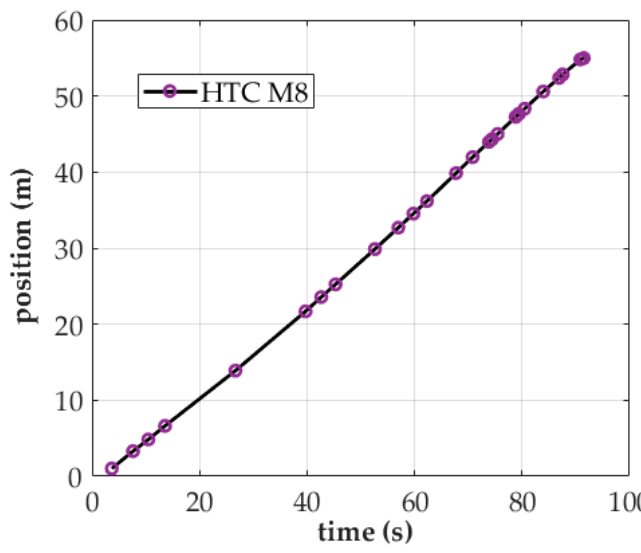
Figure 7. Time–position distribution of MS on the HTC M8 (Wi-Fi interface enabled).